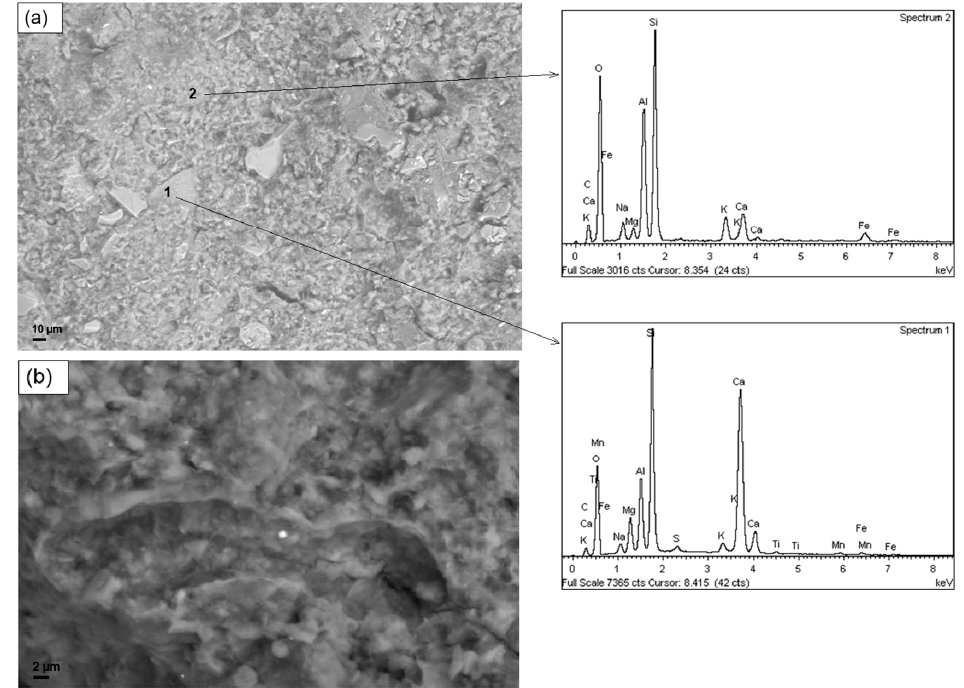
Figure 4. SEM micrographs of the reference sample G-0, at different magnifications: ( a ) SEM micrograph at magnification 1000× and EDS analyses on two spots (number 1 on an inclusion, number 2 on the matrix); ( b ) SEM micrograph at 5000× magnification.